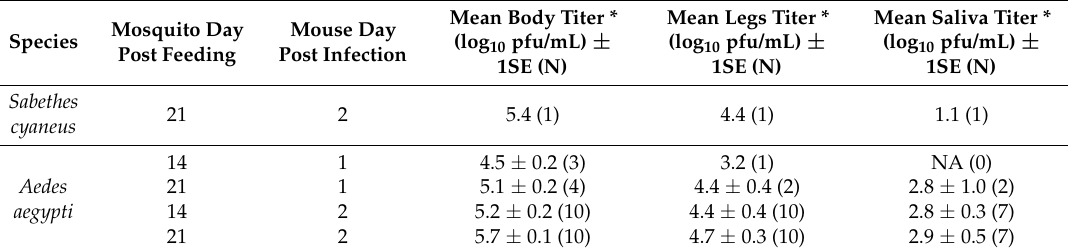
Table 3. ZIKV titer in infected tissues from Sabethes cyaneus and Ae. aegypti . Mosquito Day Species Post